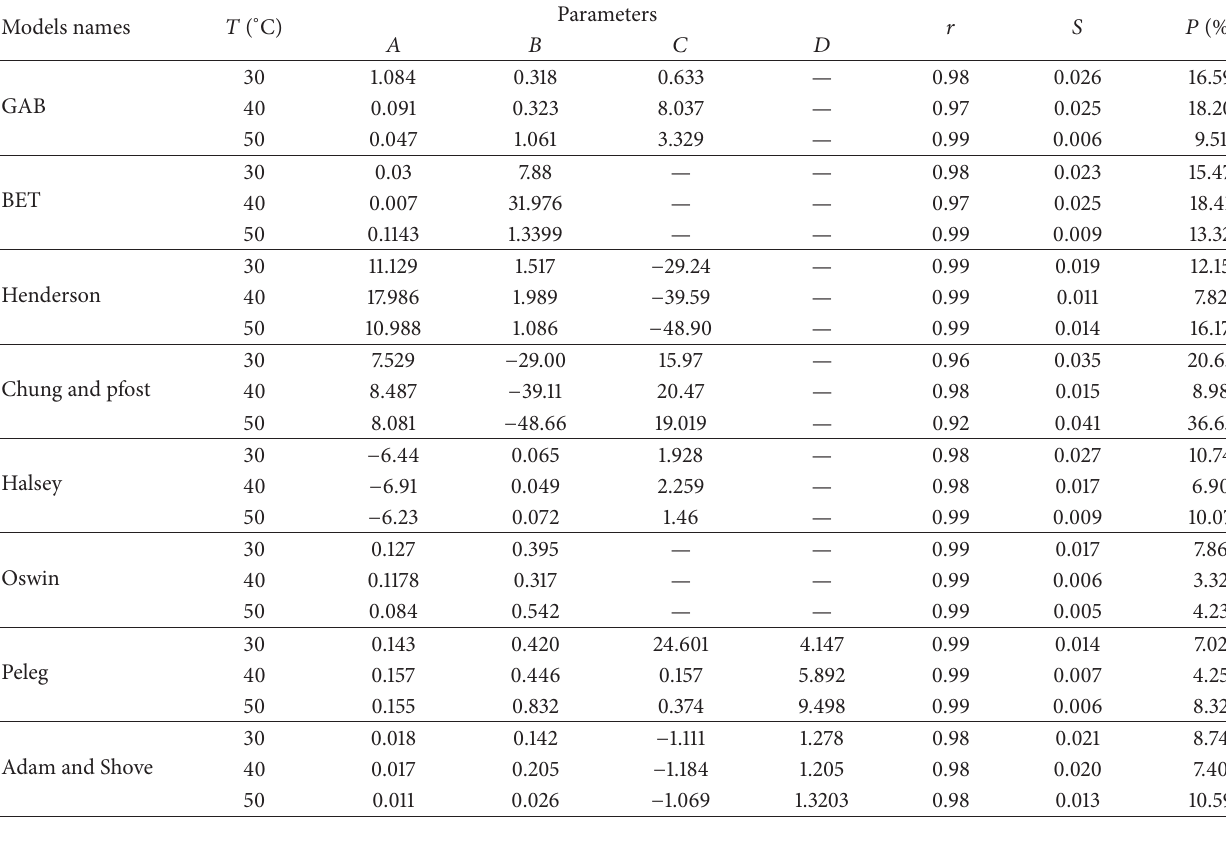
Table 4: Results of fitting of the adsorption isotherms of Ziziphus spina-christi leaves.